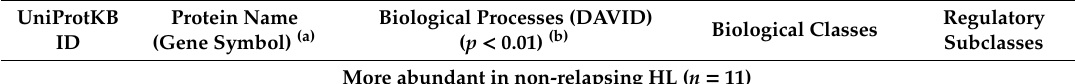
Table 3. Biological processes (DAVID) and biological classes (this study) in which the 18 validated di ff erentially abundant proteins